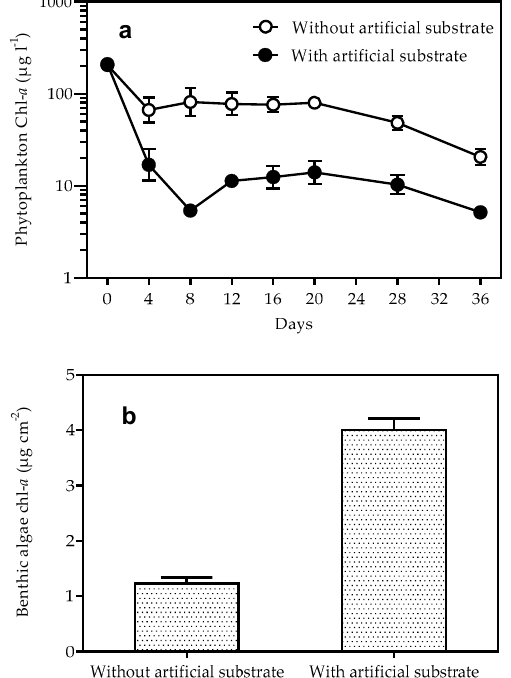
Figure 4. Comparison of chlorophyll a (Chl ‐ a ) concentrations of ( a ) phytoplankton; and ( b ) benthic algae at the end of experiment with and without artificial substrate.